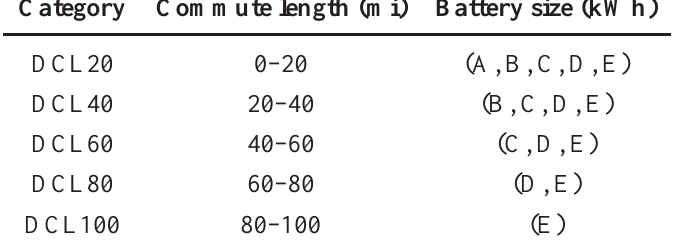
Table 2. Battery and commute length association. DCL, driver commute